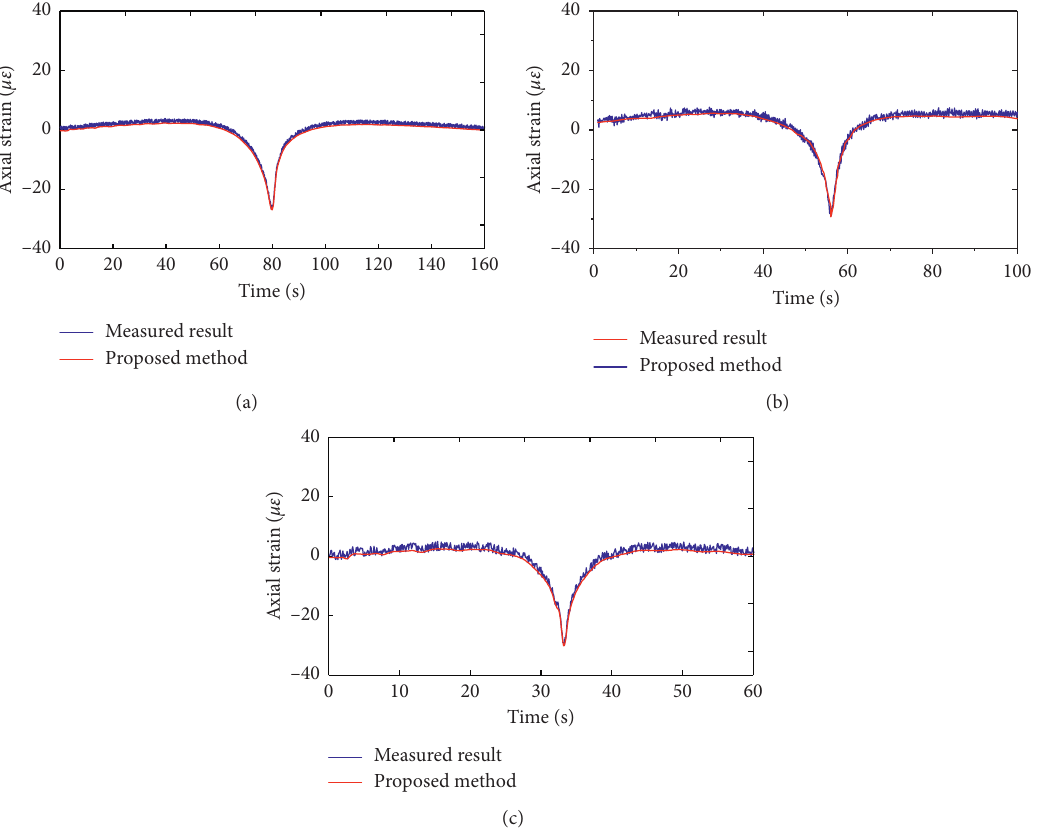
Figure 10: The comparison of dynamic strain results. (a) 20 km/h; (b) 30km/h; (c) 50 km/h.